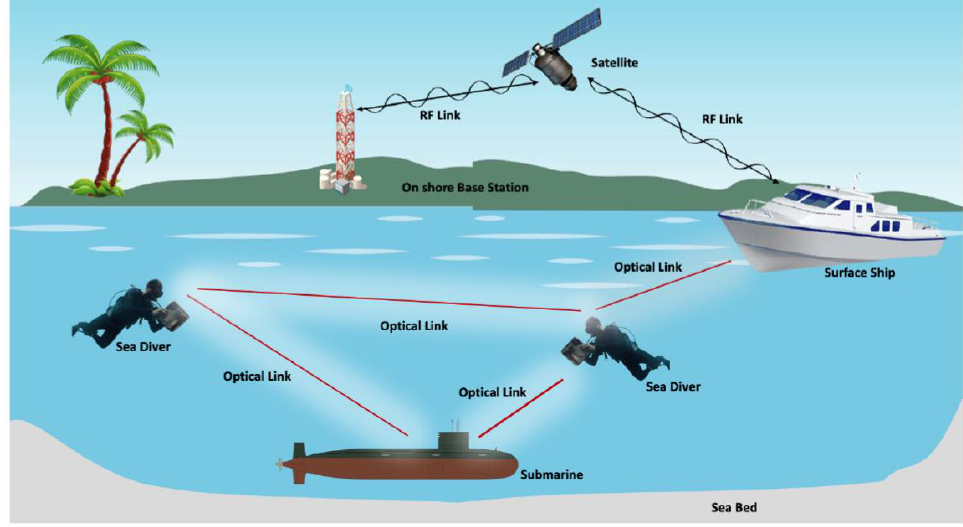
Figure 14. Line-of-sight OWC for optical IoUT [126].